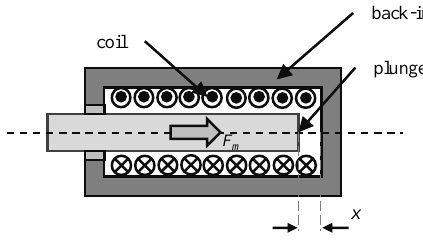
Figure 1. Working principle of a solenoid